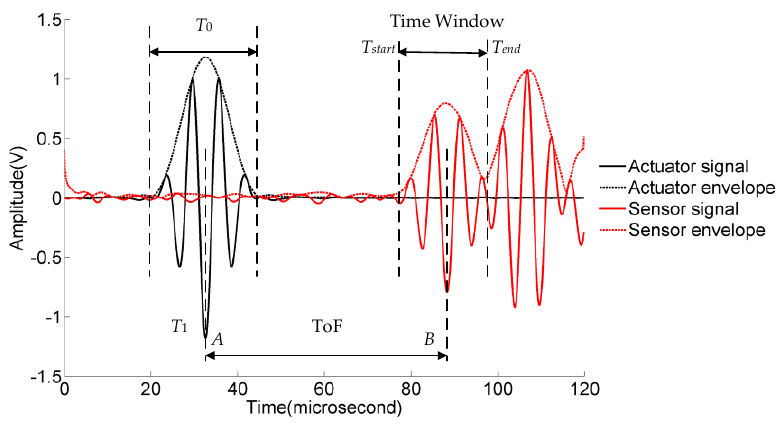
Figure 4. The mechanism of the group velocity and time window calculation.